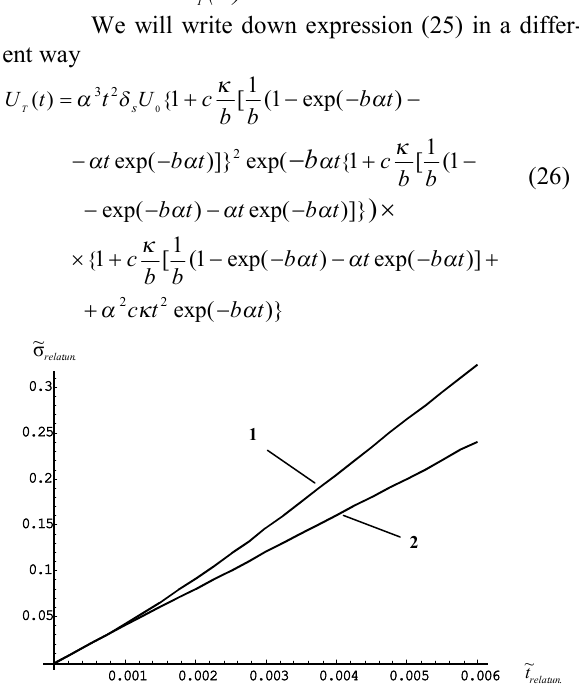
Fig 2. Dependencies of tension change (in relative units) in lo- cal area of heterogeneity with constant speed of specimen load- ing: 1 - k =0,4; 2 - k =0. For both graphs a =40,